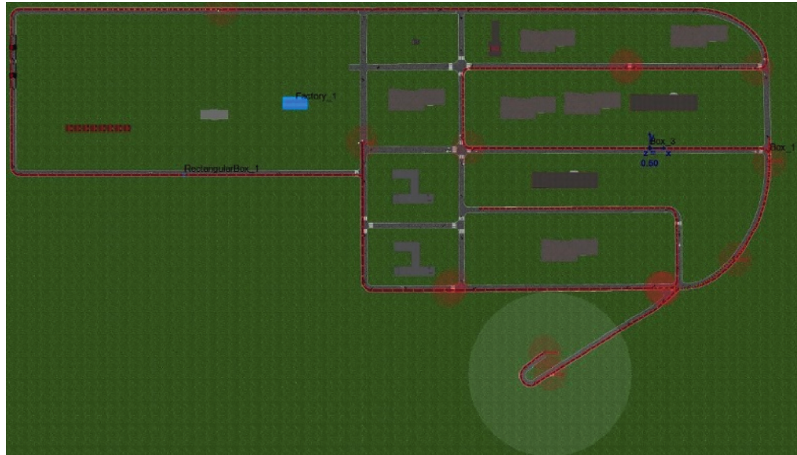
Figure 15: Simulation scenario